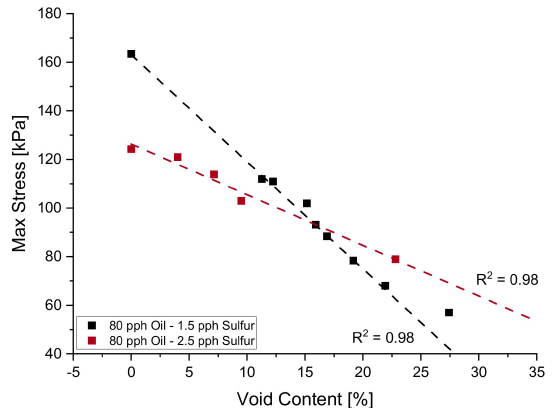
Figure 24. Plot describing the similarity of unique blends by varying void